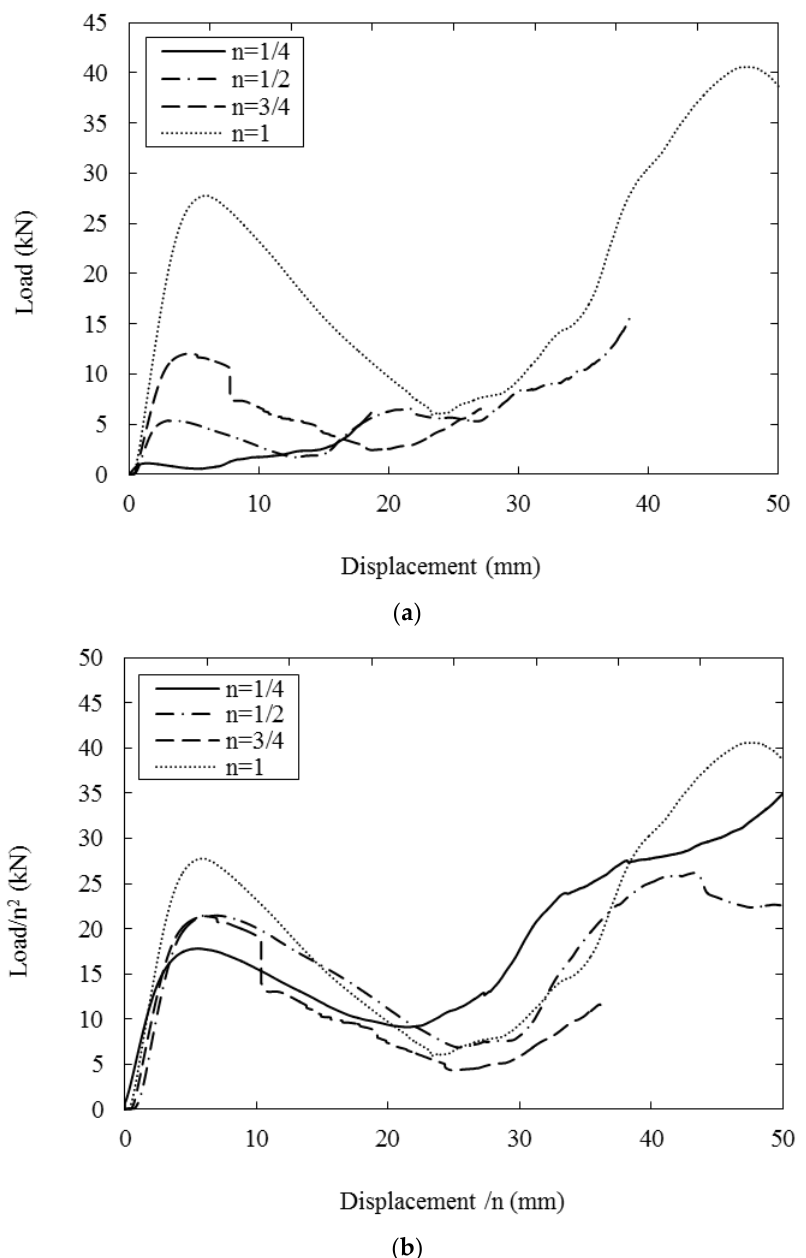
Figure 11. ( a ) Typical load – displacements traces following tests on the four scaled sizes of lattice structure. ( b ) Typical scaled load – displacements traces following tests on the four scaled sizes of lattice structure.